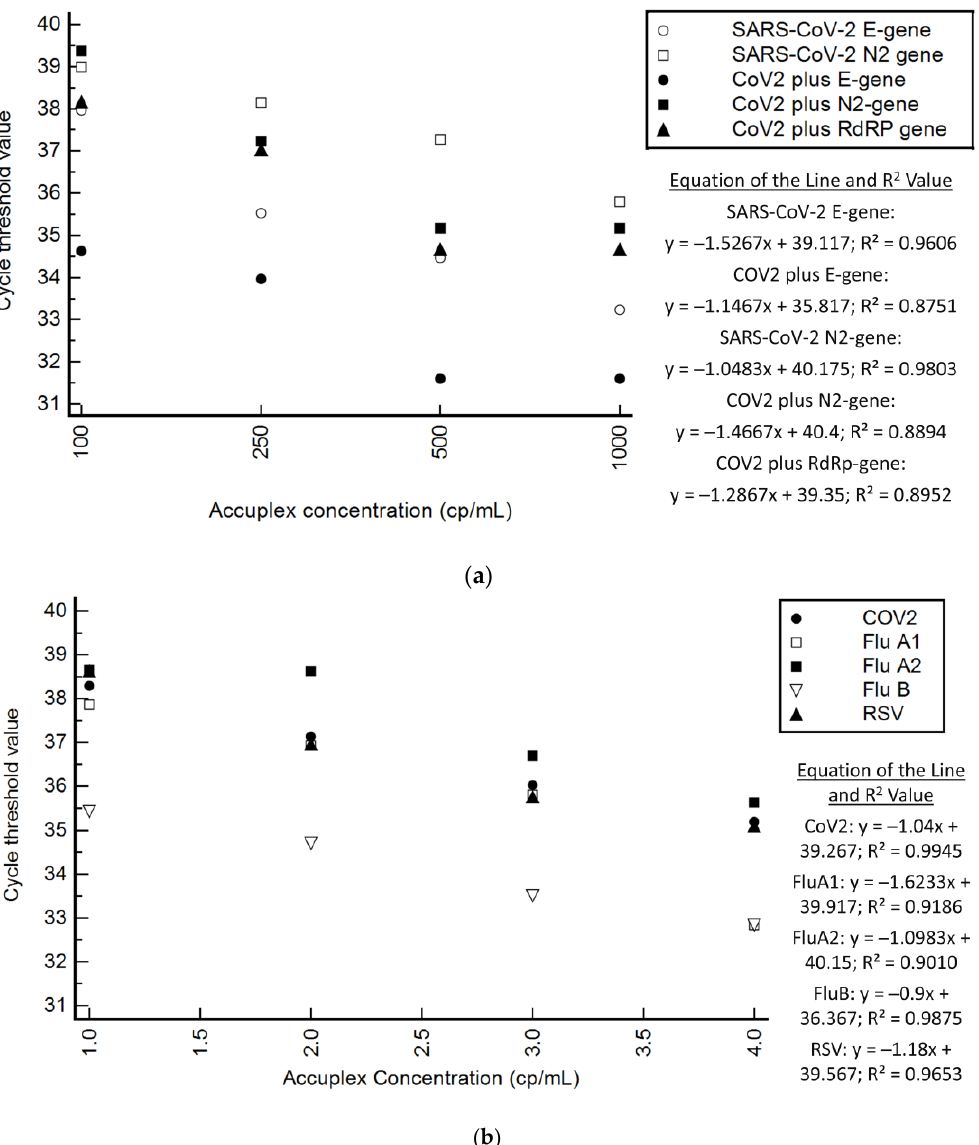
Figure 2. Regression analysis of the Xpert ® Xpress SARS-CoV-2, Xpert ® Xpress CoV-2 plus and Xpert ® Xpress CoV-2/Flu/RSV tests, including the equation of the line and R 2 values. ( a ) Xpert ® Xpress SARS-CoV-2 and Xpert ® Xpress CoV-2 plus ; ( b ) Xpert ® Xpress CoV-2/Flu/RSV plus .